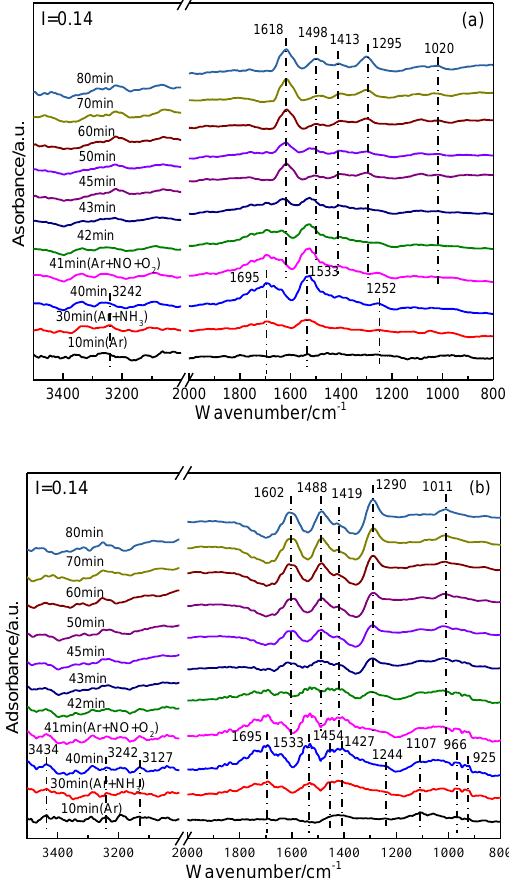
Figure 8. DRIFT spectra of SOC ( a ) and SSOC ( b ) successively exposed to 1000 ppm NH 3 , 1000 ppm NO + 15% O 2 for different time under 300 ˚